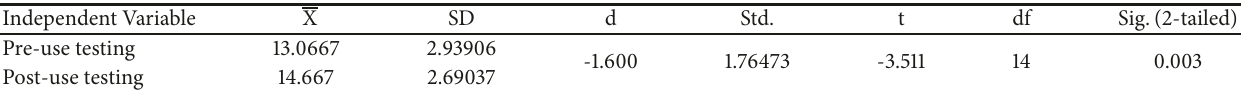
Table 3: Comparison of pre-use and post-use tests of the office furniture and workplace facilities to improve work effectiveness of people with physical disabilities in department stores, retail and wholesale companies for 15 people. A composite score was given by the users based on safety, basis in universal design, usability, and suitability for the workplace (0-5 scores were assigned for each category with a total possible score of 20)